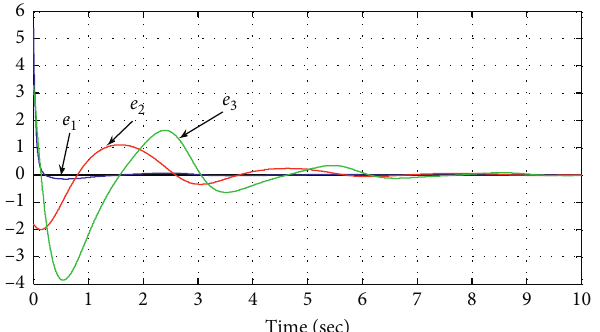
Figure 5: Time evolution of the estimation error e .